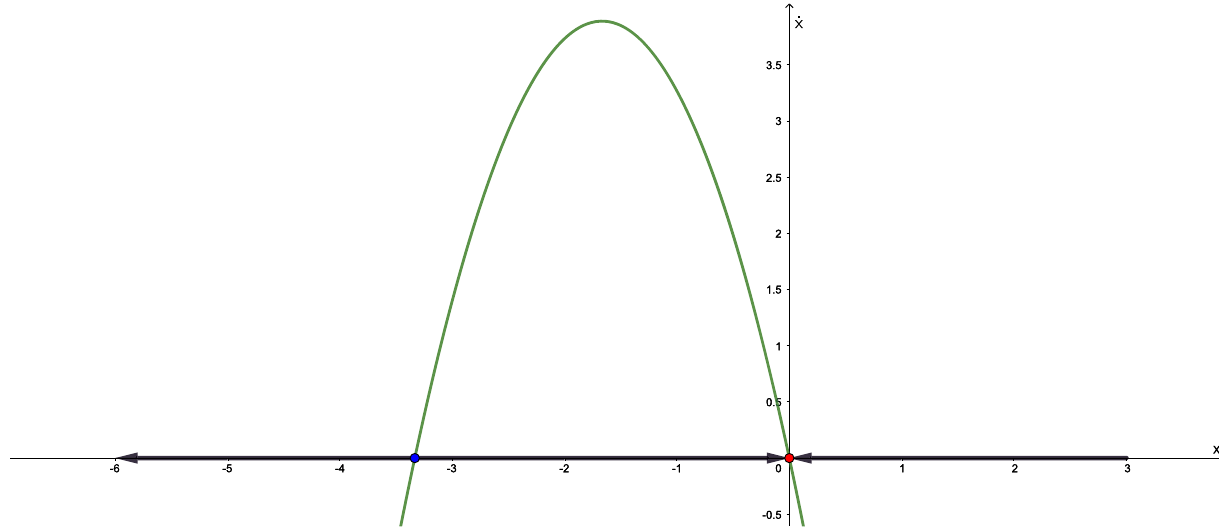
Fig. 5 1-Dimensional flow of the system (67), for μ = − 0 . 7. All the flows are topologically equivalent for μ on the interval − 1 < μ < 0 Fig. 6 Real parts of λ i corresponding to the equilibrium point P 8 for C 2 ≥ 3 4 and γ = 1, showing that in general it has saddle